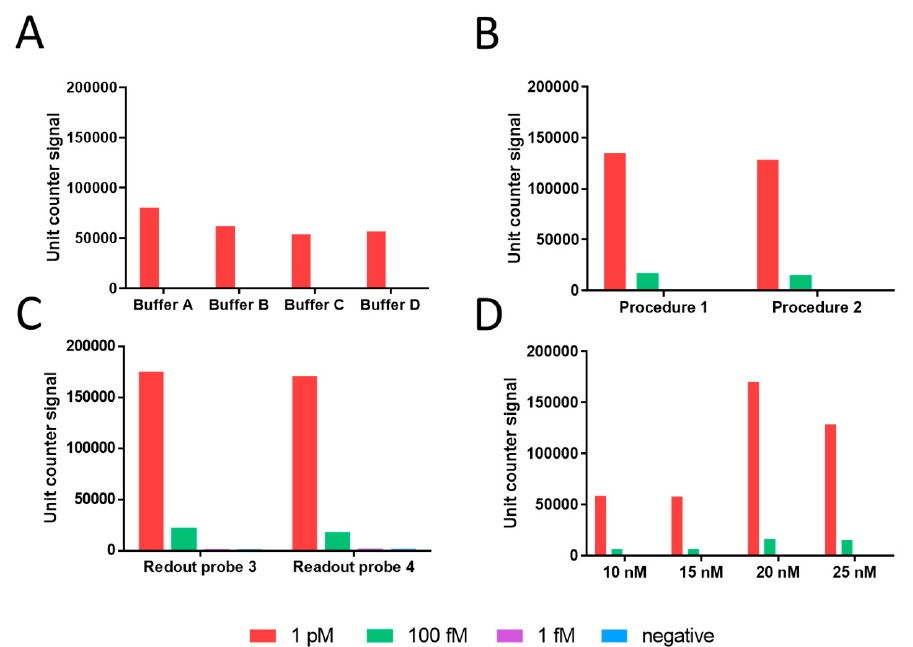
Figure 4. Results for the optimization of the rolling circle amplification. The results are shown as bars including the Unit counter signal. ( A ). Hybridization buffer optimization. ( B ). Labelling tem- perature optimization (Procedure 1: incubation at 75 °C for 2 min + 37 °C for 45 min; Procedure 2: incubation at 37 °C for 45 min); ( C ). Readout probe sequence. ( D ): Readout probe optimization. Further experimental details can be found in the main text. In all instances, the negative control without the DNA template, were performed (blue bar).